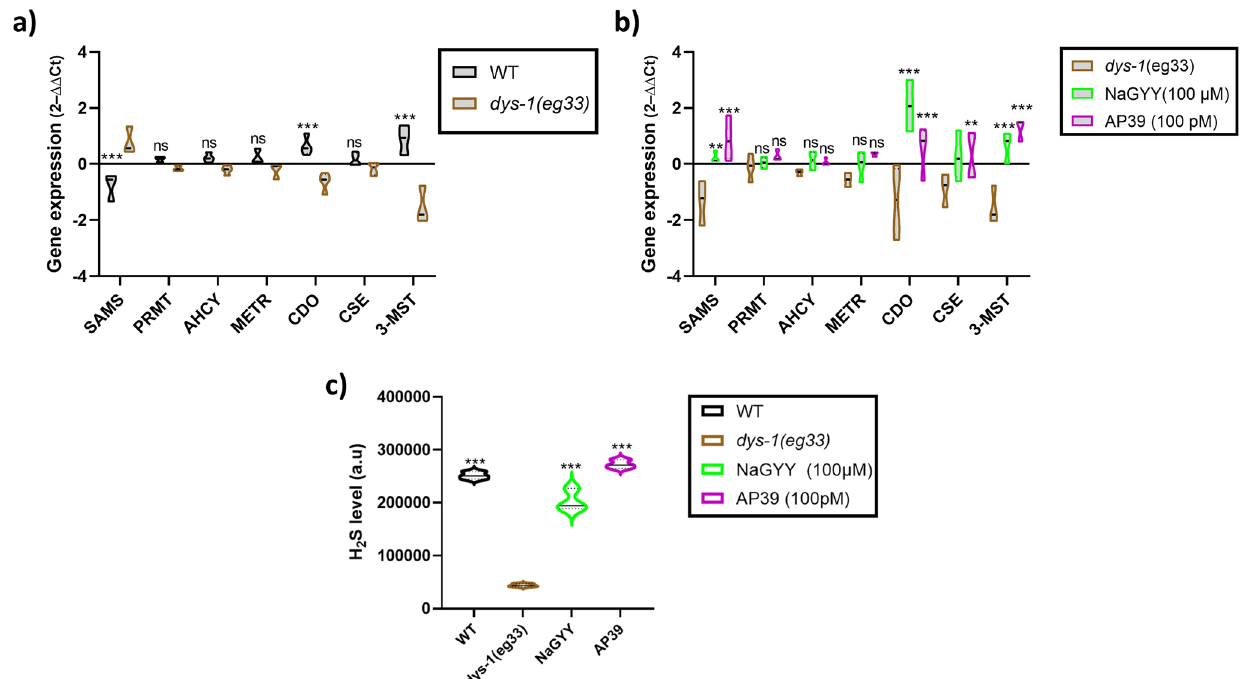
Fig. 1 DMD animals have alterations in sulfur metabolism and reduced H 2 S levels. a Relative quanti fi cation mRNA levels of enzymes associated with sulfur metabolism in wt and dys-1(eg33) animals. An increase can be seen in SAMS (s-adenosylmethionine synthetase), CDO (cysteine dioxygenase) and 3-MST (3-mercaptopyruavate transferase) in dys-1(eg33) animals. b Increased expression can be seen in SAMS, CDO, CSE (cystathionine- γ -lyase) and 3-MST with NaGYY and AP39 treatment. There were no differences in PRMT (methyl transferase), AHCY (s-adenosylhomocysteine hydrolase) or METR (methionine synthase). Data are mean ± SD from three biological repeats using 150 – 200 animals. Results were analysed with a two-way ANOVA. All signi fi cance points are compared to dys-1(eg33) . *** P < 0.0001, ** P < 0.01, * P < 0.05, ns P > 0.05. c Fluorescence intensity of the AzMC signal, normalised to protein content. There is a decline in global H 2 S levels in the dys-1(eg33) animals compared to wt , which is increased by NaGYY and AP39 treatment. Data for each treatment are from 270 animals across three biological repeats. Results were analysed with a one-way ANOVA. All signi fi cance points are compared to dys-1(eg33) . *** P <